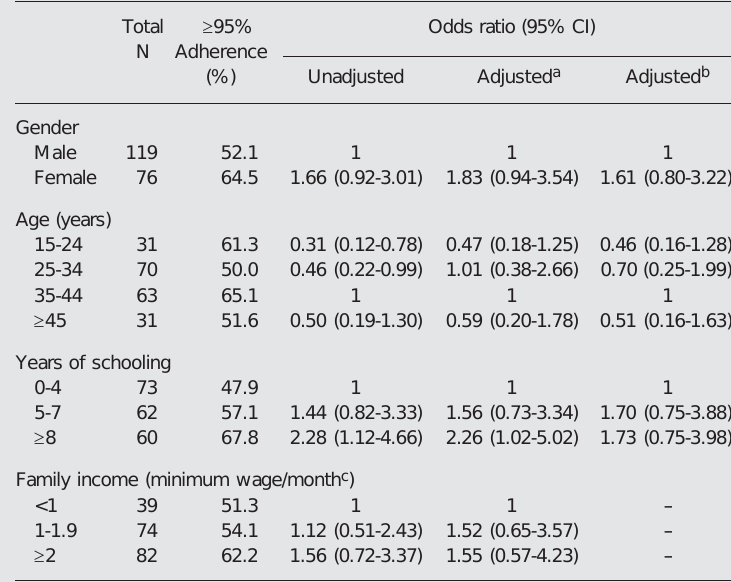
Table 2. Total number of patients in each group and percentages of adherent patients/ group ( (cid:2) 95%